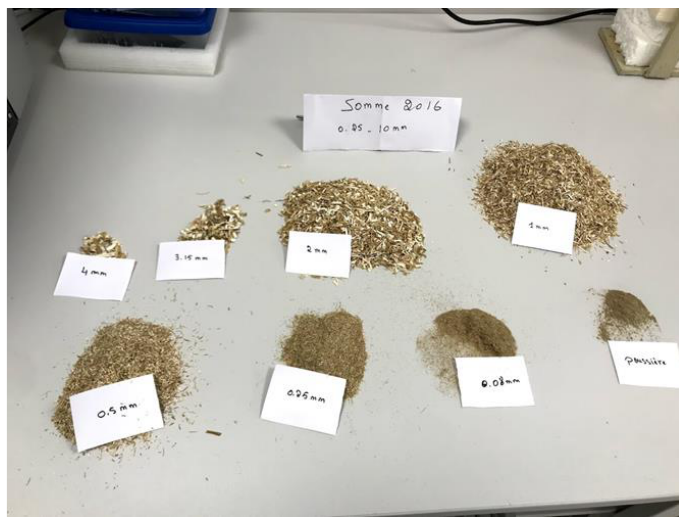
Figure 3. The different sizes of rapeseed straw after the sieving test.